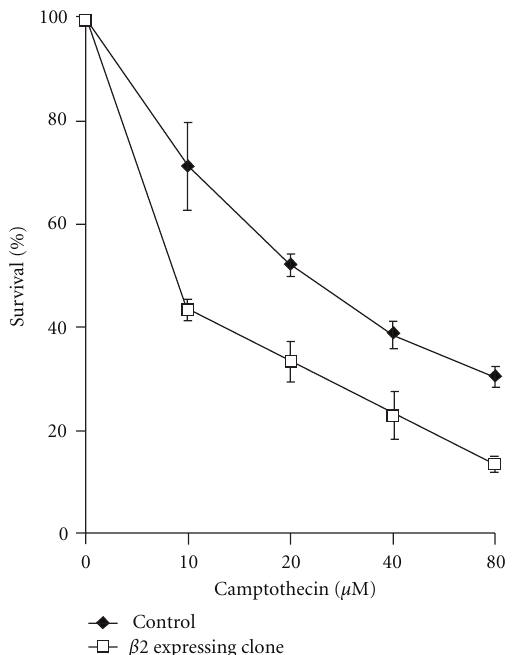
Figure 4: The over-expression of the β 2 subunit of proteasome increases the sensitivity to camptothecin. Cells expressing the β 2 subunit and cells containing the pcDNA6/myc vector (control cells) were seeded at the density of 3 × 10 2 per plate. After 24 hours, cells were treated for one hour with camptothecin at the following concentrations: 10 μ M, 20 μ M, 40 μ M, and 80 μ M. After 7 days, the clones were stained with crystal violet and were counted.